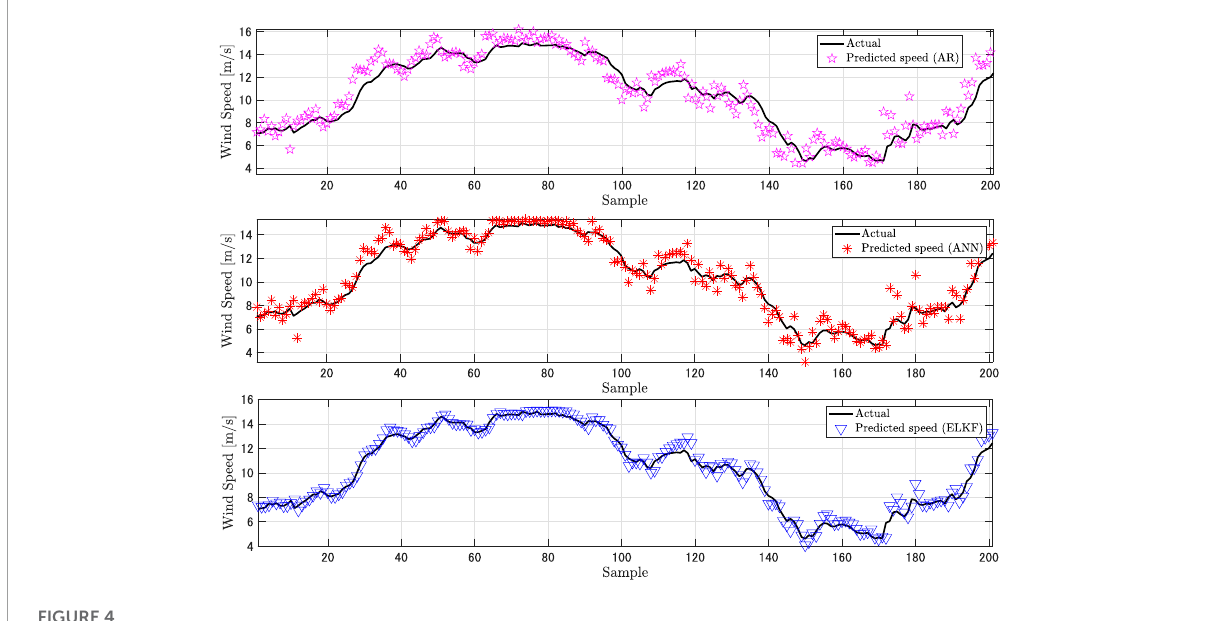
FIGURE 4 Results of wind speed prediction (predictive horizon: one-step): AR, ANN, and ELKF.